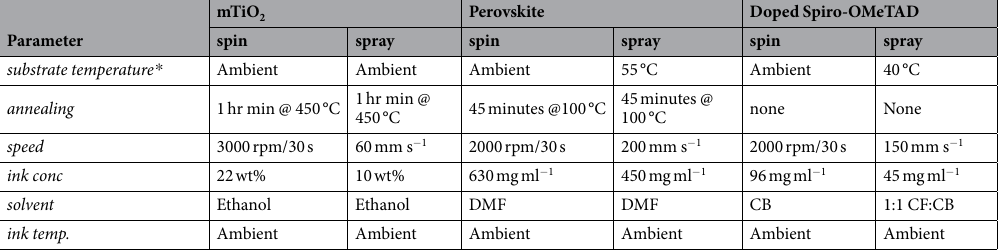
Table 1. Summary of thin-film deposition protocols ( * ) refers to substrate temperature during ink